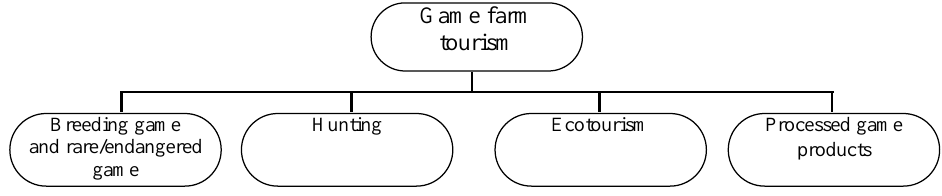
Fig. 1. Four pillars of game farm